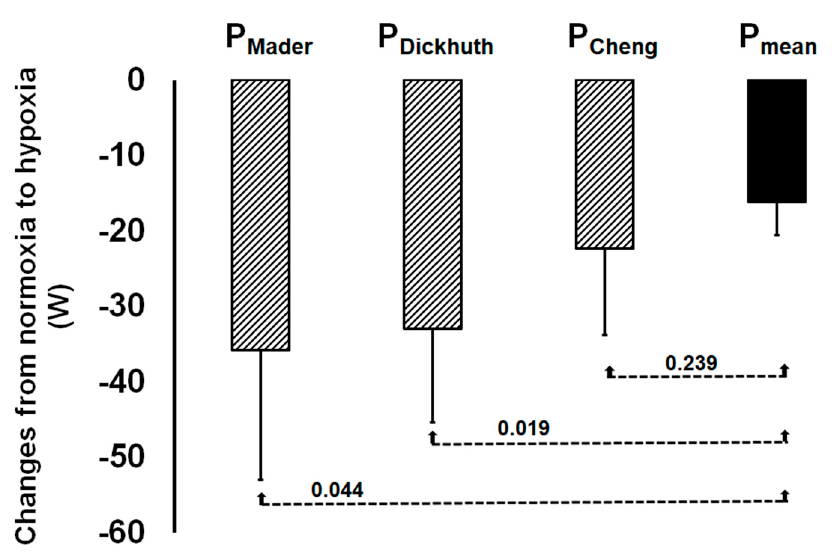
Figure 3. Hypoxia-related changes in power output at the three lactate thresholds (P Mader , P Dickhuth , P Cheng ) and in mean power output during the maximal 30-min time trial (P mean ) [13–15]. P-values refer to a comparison to P mean . Values are means ± SD.